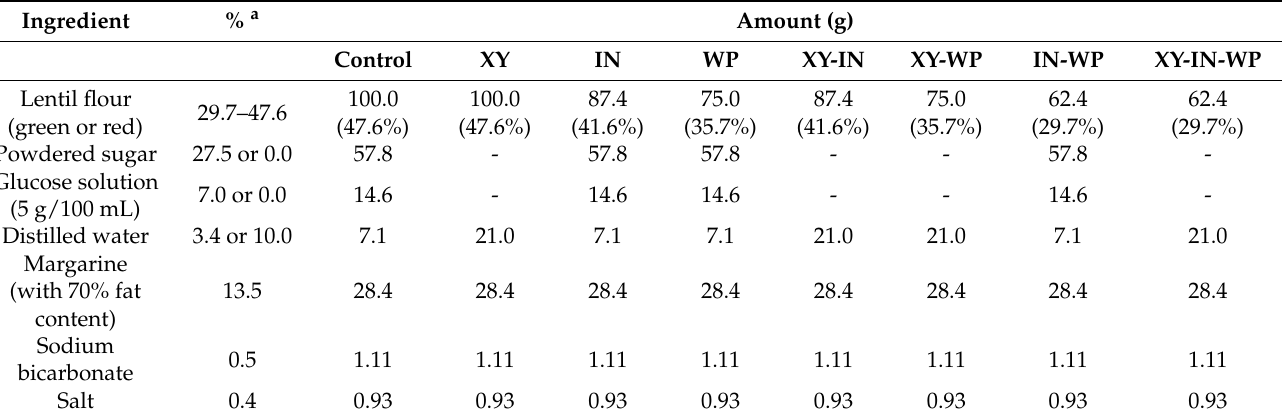
Table 1. Recipe of the prepared